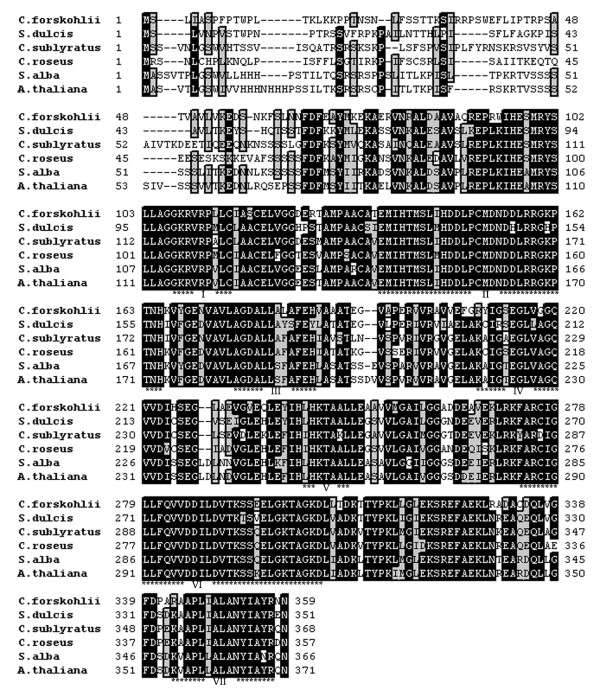
Amino acid sequence alignment of C. forskohlii GGPP synthase and other plant GGPP synthases. The residues boxed in black indicate the positions of at least five of the six compared sequences while the gray shading indicates similar amino acids. Dashes indicate gaps introduced for optimization of the alignment. Numbers of amino acids are indicated in the left and right margins. Asterisks show the seven domains that are highly conserved among prenyltransferases with two aspartate-rich motifs (domain II and VI). Species and accession numbers are C. forskohlii, AY515700; S. dulcis, AB034250_1; C. sublyratus, AB034249_1; C. roseus, T09966; S. alba, T10452; A. thaliana, F85434.